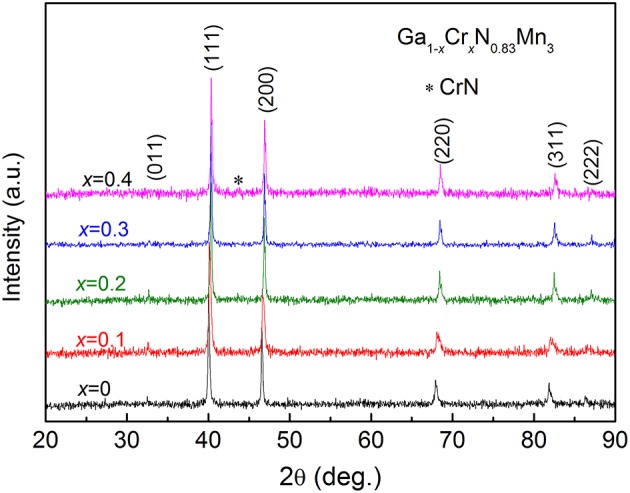
X-ray diffractions at room temperature for Ga1−xCrxN0.83Mn3 (x = 0, 0.1, 0.2, 0.3, 0.4). The asterisk marks the diffractions from CrN.